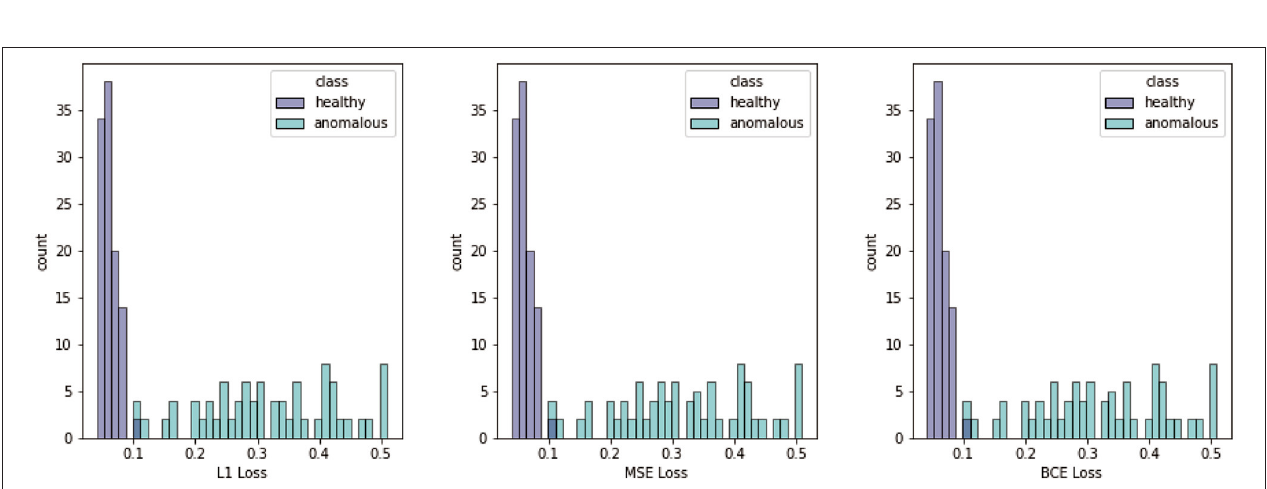
FIGURE 6 | Histograms of different losses, namely ℓ 1, MSE, and BCE. Losses are computed for all test patches containing healthy and anomalous berries.